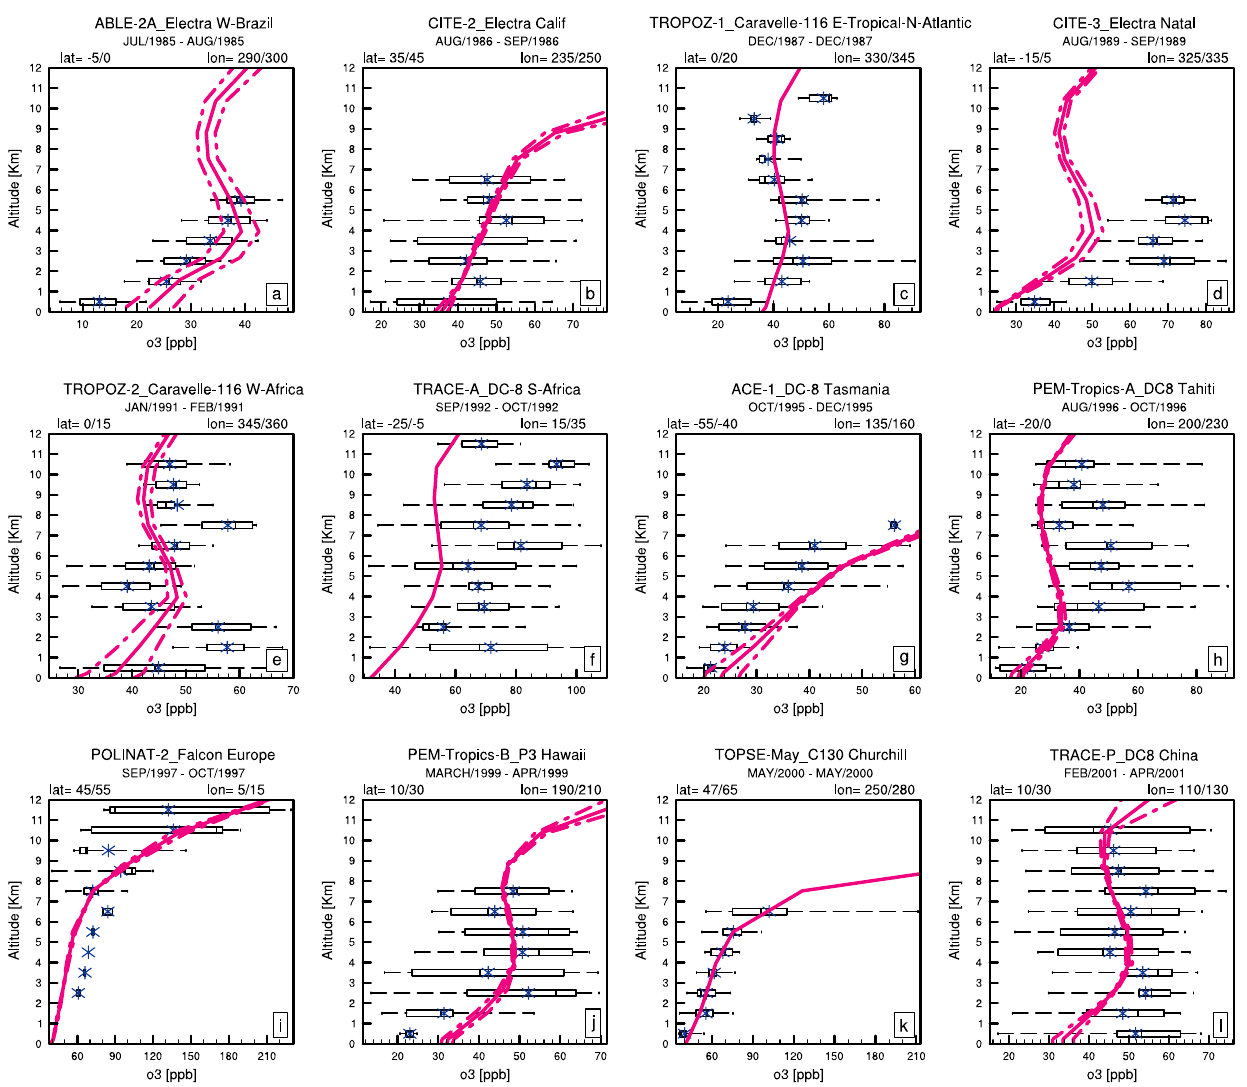
Fig. 12. Vertical profiles of campaign observation from Emmons et al. (2000) and the AC&C/SPARC ozone database for different regions. Boxes and whiskers indicate the central 50% and 90% of the observations, with a vertical bar at the median and a star in the mean. The AC&C/SPARC ozone database is averaged over the same latitudes as the observations. Mean and standard deviations over the same time period of the campaign are shown by the solid and dashed